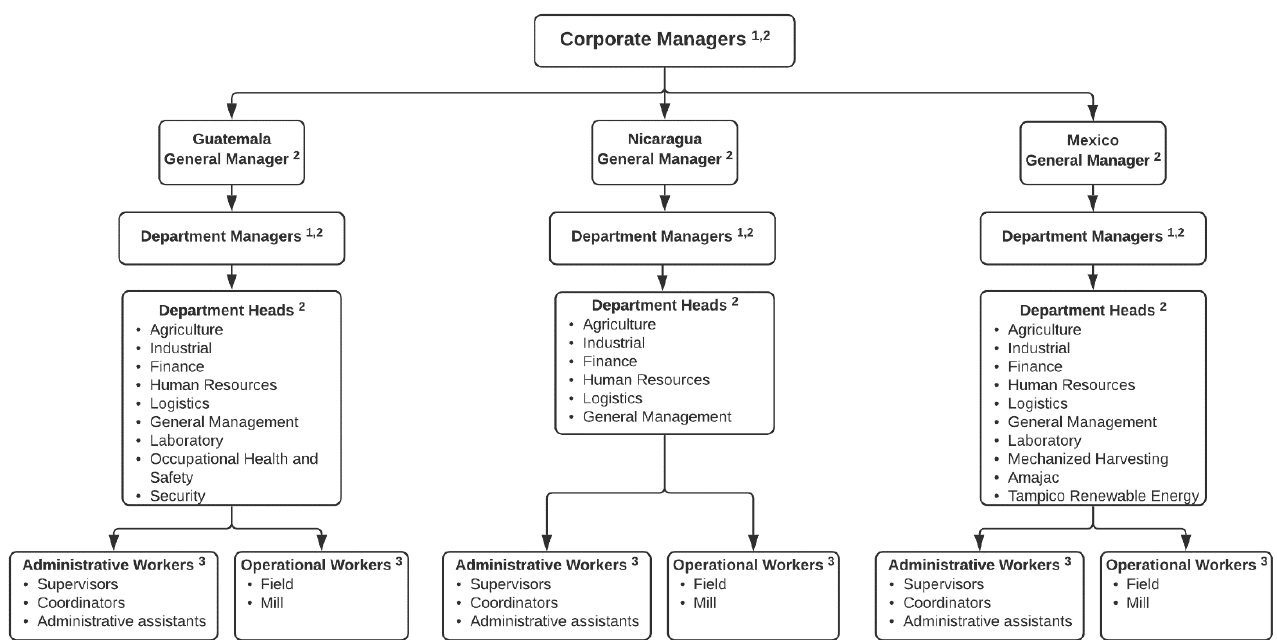
Figure 2. Pantaleon Organizational Chart. The needs assessment was conducted at all levels of the organization, including headquarters and all departments within each national branch. Footnotes indicate employees who participated in (1) the organizational assessment (human resource managers only), (2) key informant interview and focus groups, and leadership self-assessment, and (3) the employee health and safety culture survey and the health risk assessment.